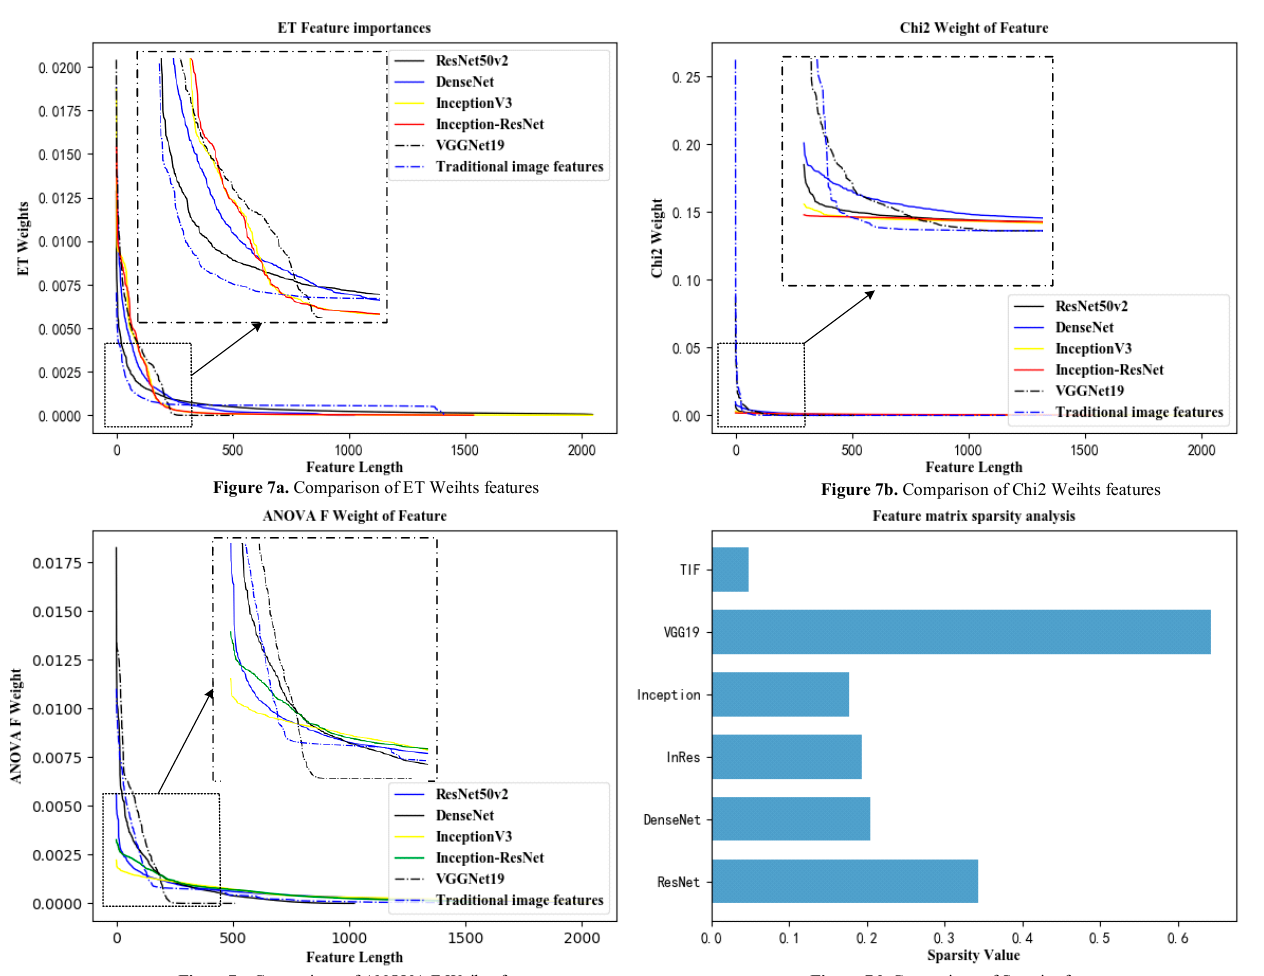
Figure7c. Comparison of ANOVA F Weihts features Figure 7d. Comparison of Sparsity features Figure 7. Analysis diagrams for deep convolutional features and traditional features of cervical cancer tissue images. (The method for calculating the weights in this figure is shown in Equation (21).) VGG19 means VGGNet19, InRes means Inception-Resnet, Resnet means ResNet50 V2, DenseNet means DenseNet121, and Inception means Inception V3.